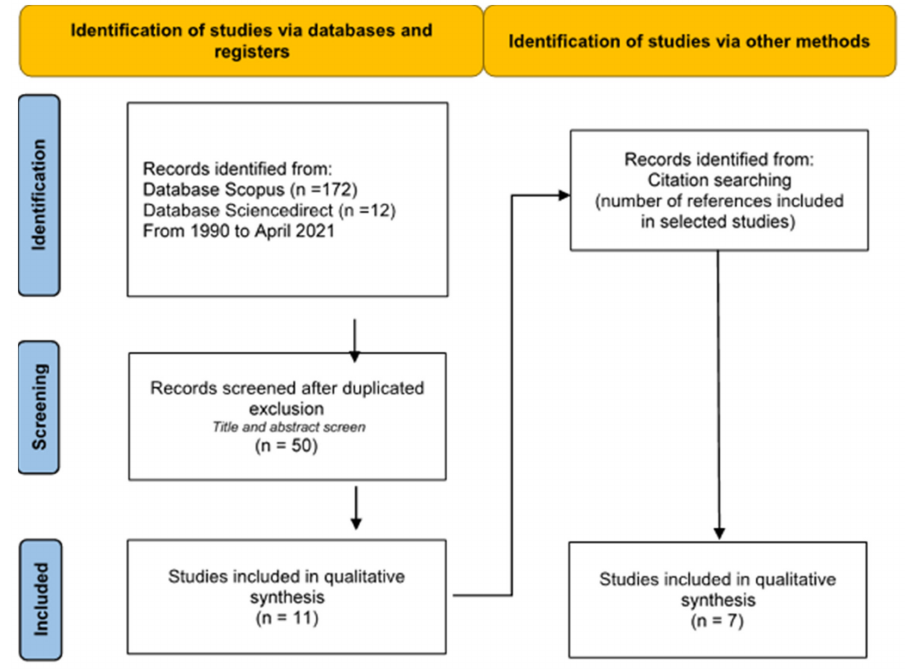
Figure 1. Flow diagram describing study selection process of scientific